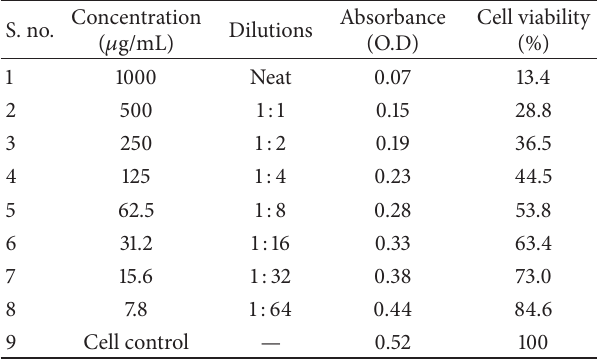
Table 3: Anticancer effect of copolyester on MCF7 cell